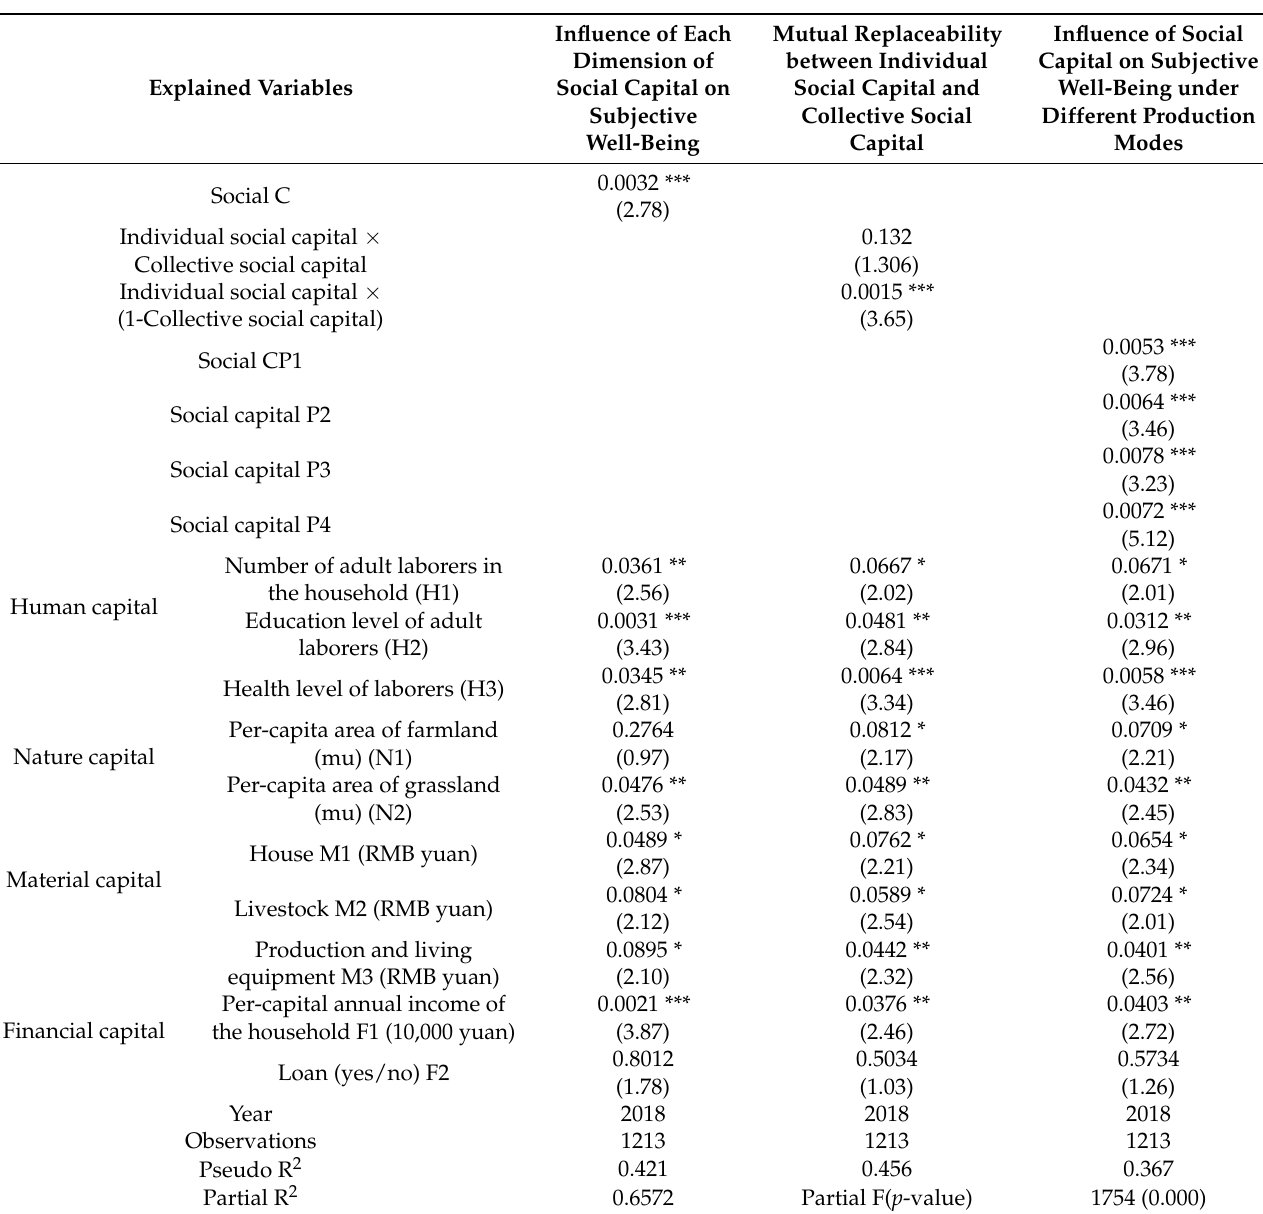
Table 7. Robustness test results by IV